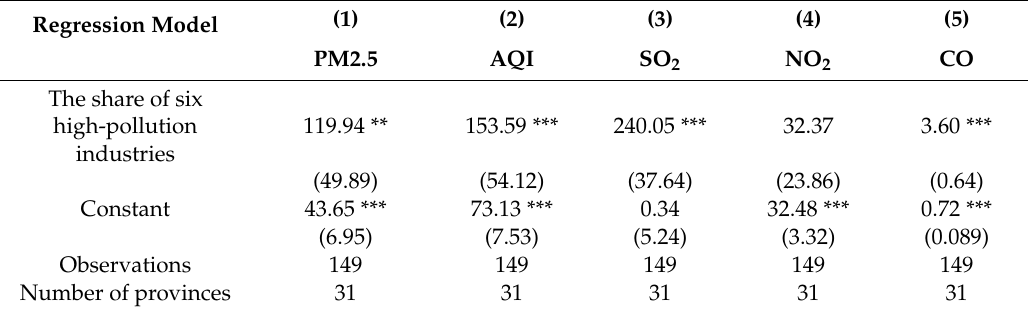
Table 2. The contribution of the six polluting industries to local air pollution